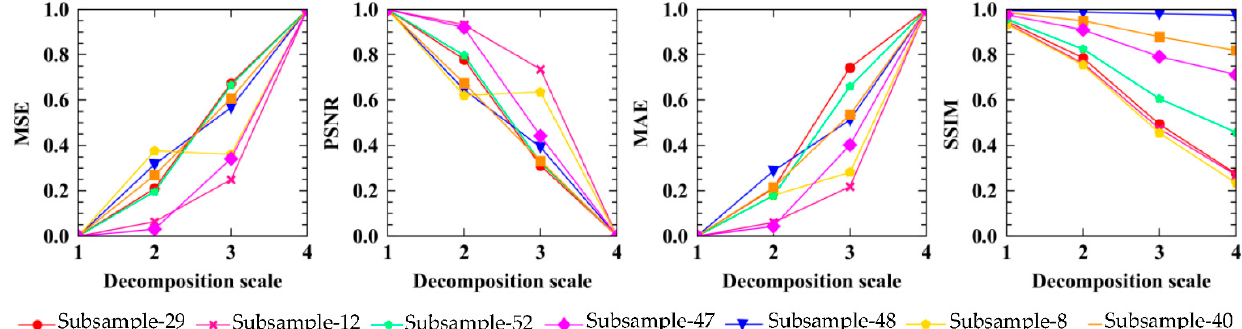
Figure 6. Calculation of the texture image evaluation index after wavelet reconstruction.